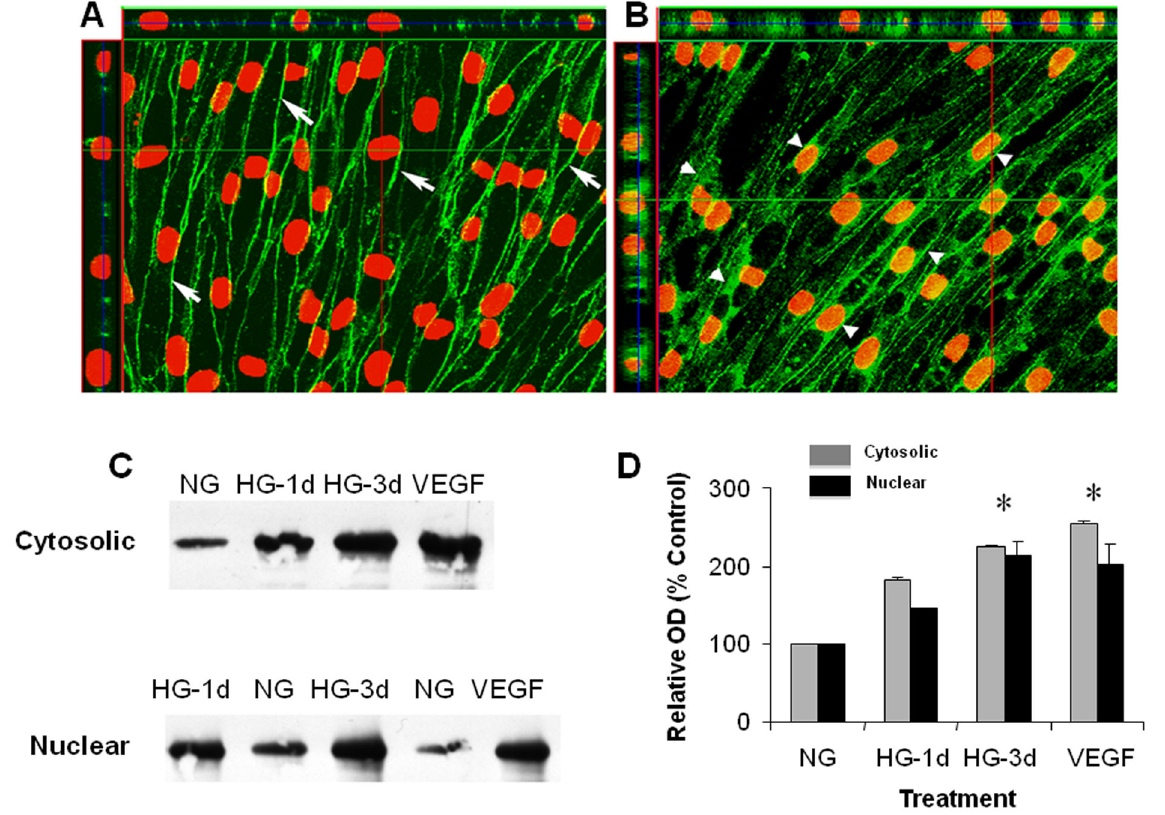
Figure 5. High glucose-induced nuclear translocation of. β-catenin. Endothelial cells were grown in serum-free medium with normal glucose (NG, 5.5mM) or high glucose (HG, 25 mM) for 3 days, fixed and processed for immunocytochemistry and confocal microscopy or used for cell fractionation. Confocal imaging of NG cultures using anti β-catenin antibody (green) and propidium iodide nuclear staining (red) shows membrane bound β-catenin (arrows) (A). Following high glucose treatment β-catenin was redistributed into the cytosol (arrowheads) and nucleus (as shown in z-series optical slices above and at left) (B). Western blotting showed increased cytoplasmic and nuclear β-catenin following HG treatment (C). Densitomitric analysis showed significant increases in cytosolic and nuclear β-catenin levels following HG or VEGF treatment (D) (* = P < 0.05 vs Control). Gray bars represent cytosolic β-catenin. Black bars represent nuclear